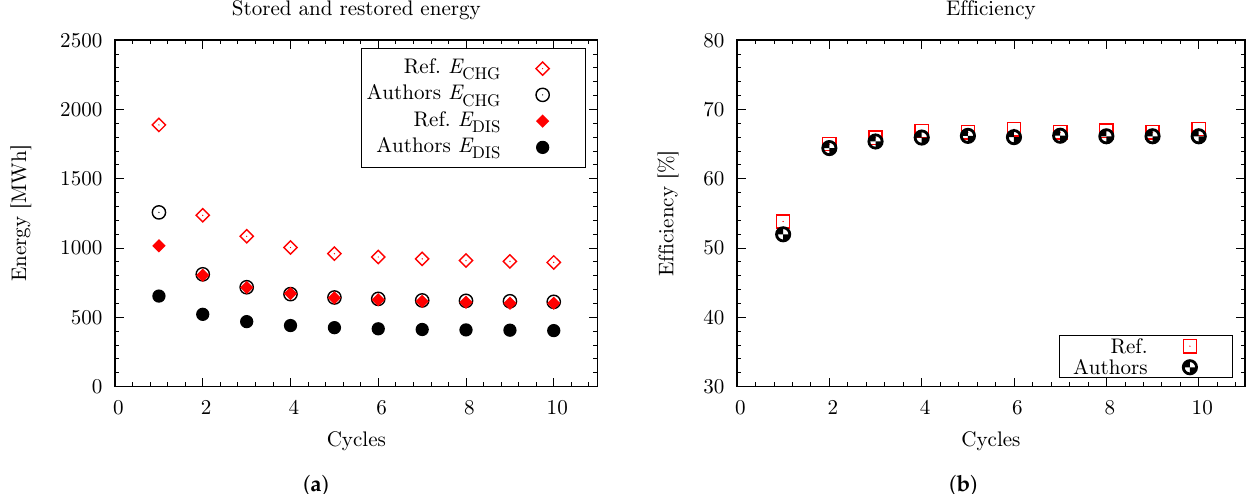
Figure 3. Energy and efficiency during the first 10 charge–discharge cycles for Desrues [21] and the present case. ( a ) In black are reported the authors’ stored energy (empty dots) during the charging process and the delivered energy (filled dots) during the discharging process. In red are shown the results of the reference. ( b ) Dots in black indicate the efficiency in the authors’ case, defined as the ratio between restored and stored energy. These trends show good accuracy in reproducing the process efficiency, compared with those described in the reference ( red empty